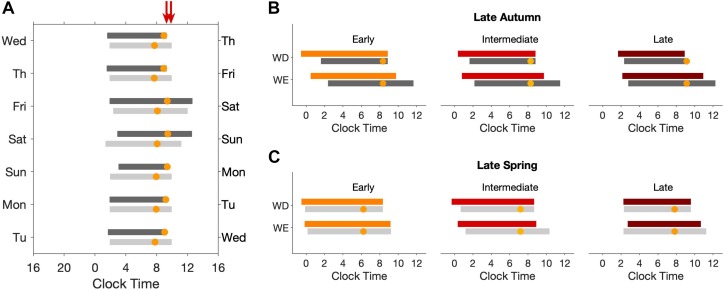
Model predicted weekday and weekend sleep times for early, intermediate and late types in the late autumn and late spring. Raster plots (A) for sleep timing in late autumn (dark gray bars) and late spring (light gray bars) for intermediate types. The left/right hand colored arrows indicate weekday wake time during spring/autumn. (B,C) show mean computed sleep timing for weekday and weekend for early, intermediate and late groups during the late autumn (dark gray bars) and late spring (light gray bars). For comparison, the measured values are also shown (colored bars). For all panels, the time of the computed circadian minimum wake propensity is indicated by the orange circles.